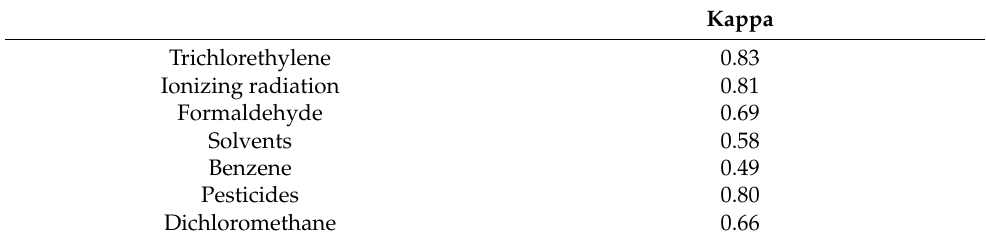
Table 5. Kappa coefficient between the exposure assessment of each harmful substance according to the ITQ questionnaire and the expert analysis, when more than 5 patients were exposed to (“unfiltered” patients), RHELYPRO Study (2017–2019).